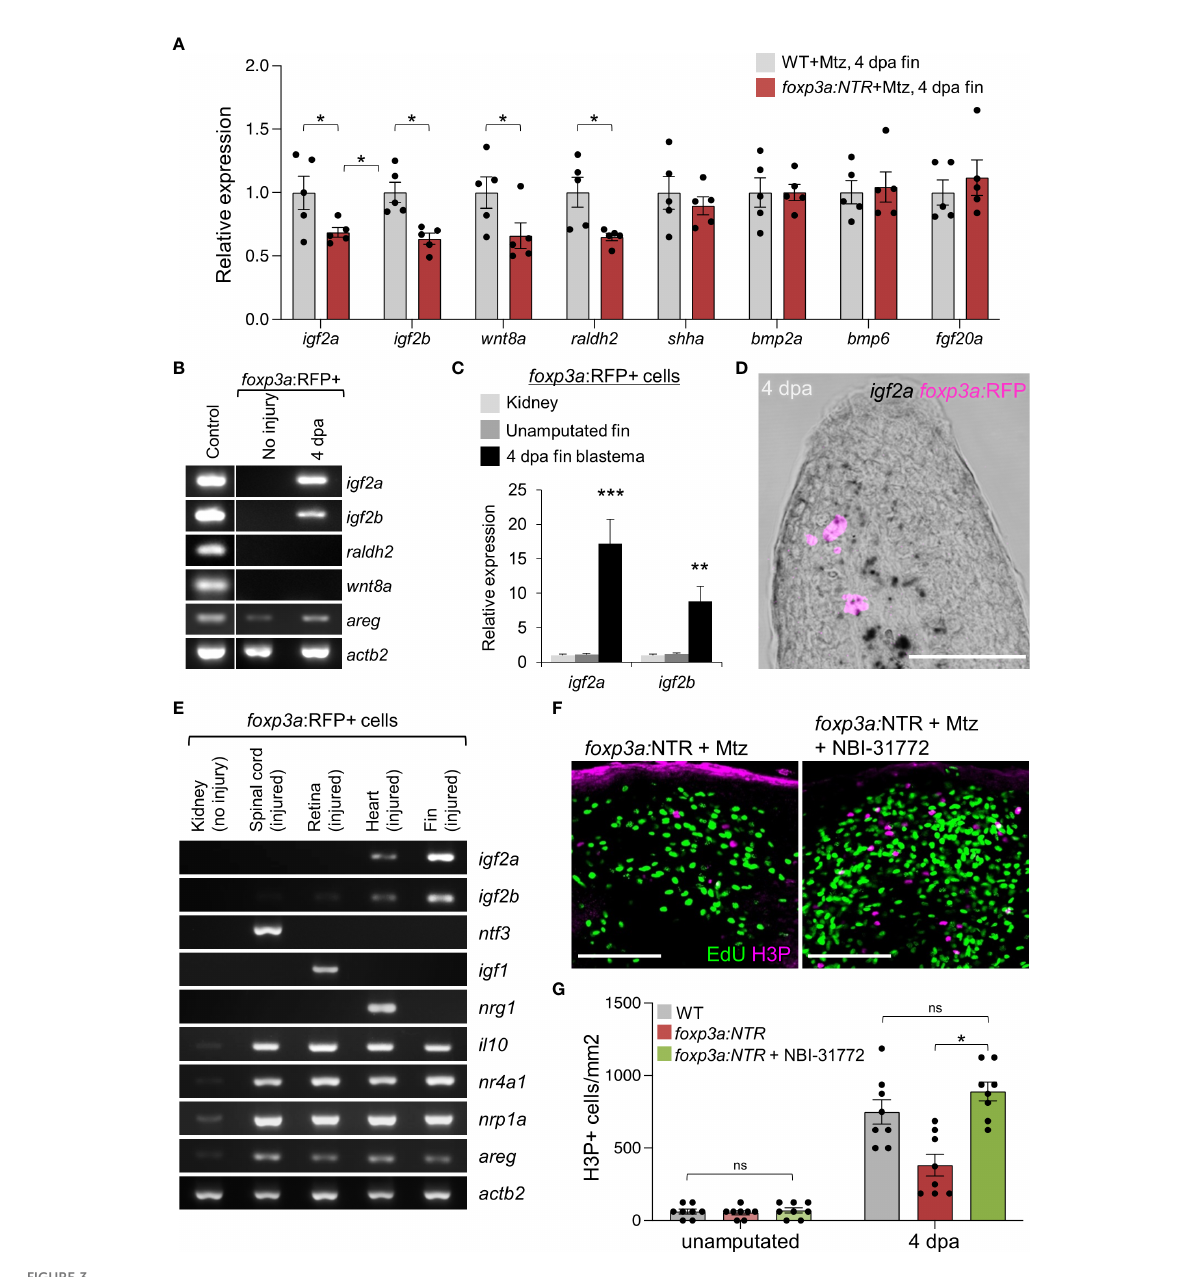
FIGURE 3 Blastemal cell proliferation during caudal fi n regeneration is regulated by Treg cells-derived pro-regenerative factors. (A) qRT-PCR analysis of growth factors expression in 4 dpa fi n blastema of wild-type and foxp3a:NTR fi sh after Mtz treatment. (mean ± SEM, n = 5, Student ’ s T-test). (B) RT-PCR analysis of growth factors expression (found signi fi cant decrease after Treg cell ablation) from puri fi ed foxp3a: RFP+ cells from unamputated and 4 dpa fi n blastema. The 4 dpa fi n blastema tissue was used as control. (C) Expression analysis of igf2a and igf2b in puri fi ed foxp3a: RFP+ cells from kidney marrow, unamputated fi n and 4 dpa fi n blastema. (mean ± SEM, n = 5, Student ’ s T-test). (D) In situ hybridization using RNAscope and immuno fl uorescence against TagRFP showing igf2a mRNA expression within in fi ltrated foxp3a: RFP+ cells of a 4 dpa fi n blastema. (E) RT-PCR analysis of growth factor expression of puri fi ed foxp3a: RFP+ cells from kidney, 7 days post injured (dpi) spinal cord, 4 dpi retina, 7 dpi heart, and 4 dpa fi n blastema tissues show tissue-speci fi c growth factor secretion pattern of Treg cells. (F) The wholemount preparation of 4 dpa fi n with EdU and H3P immunostaining in Treg ablated fi sh and fi sh with NBI-31772 application after Treg ablation. EdU was injected intraperitoneally at 30 min before fi n tissue collection. (G) Quanti fi cation of H3P+ cells in unamputated and 4 dpa fi n blastema of wild- type, Treg ablated fi sh, and fi sh with NBI-31772 application after Treg ablation (mean ± SEM, n = 8-9, Mann – Whitney U test). *P < 0.01; **P < 0.001; ***P < 0.0001; ns, not signi fi cant; Mtz, metronidazole; NTR, nitroreductase; Sacle Bars, 50